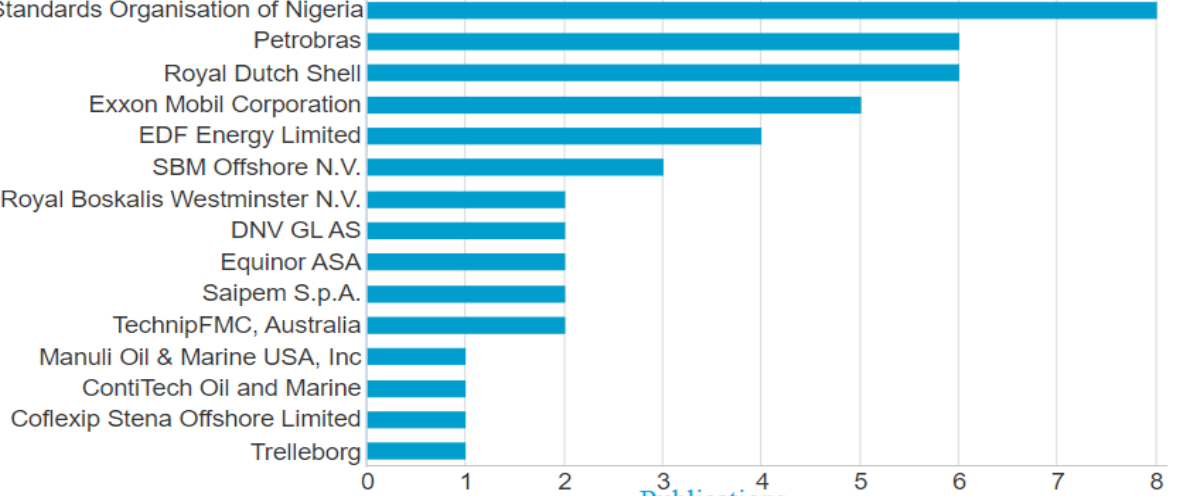
Figure 10. The affiliations by academic institutions for the research on “marine hose” (data retrieved from Scopus database, 24 July 2022).